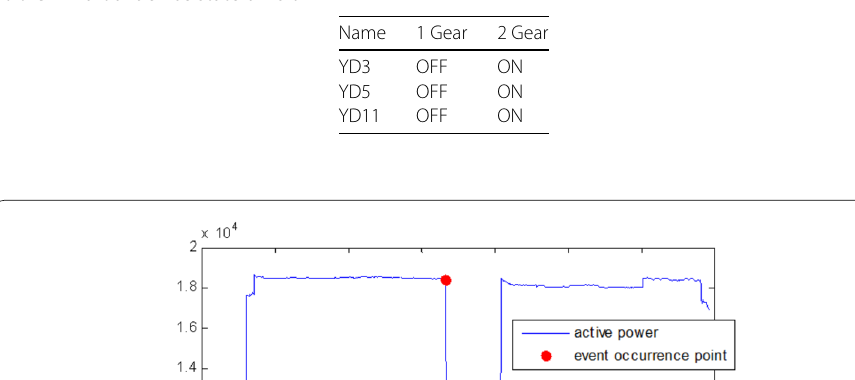
Table 2 Partial device state